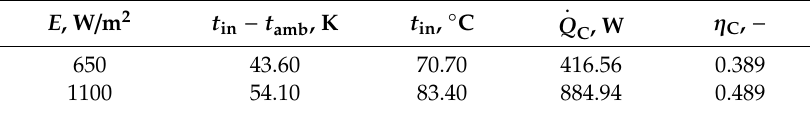
Table 10. Main technical parameters of the modified solar thermal